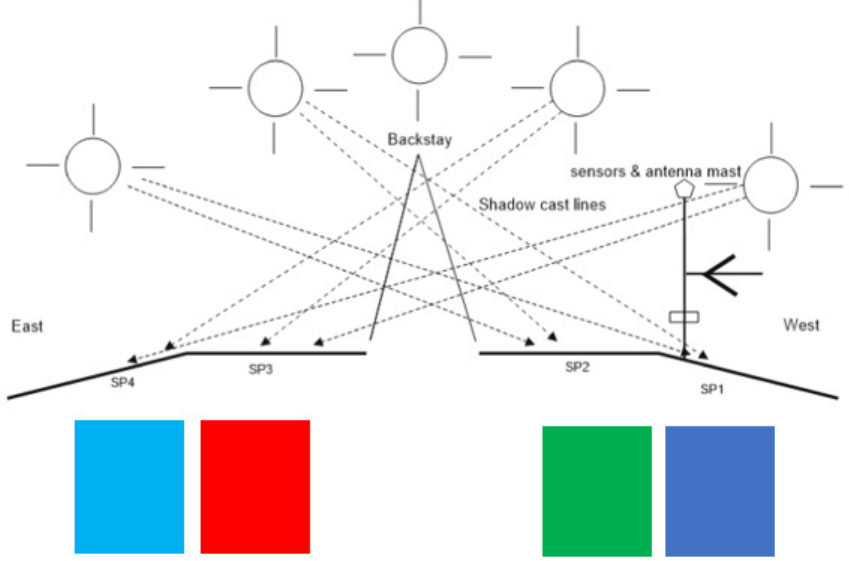
Figure 7. PVMs installation viewed from the bow, with possible projections of shadow lines.